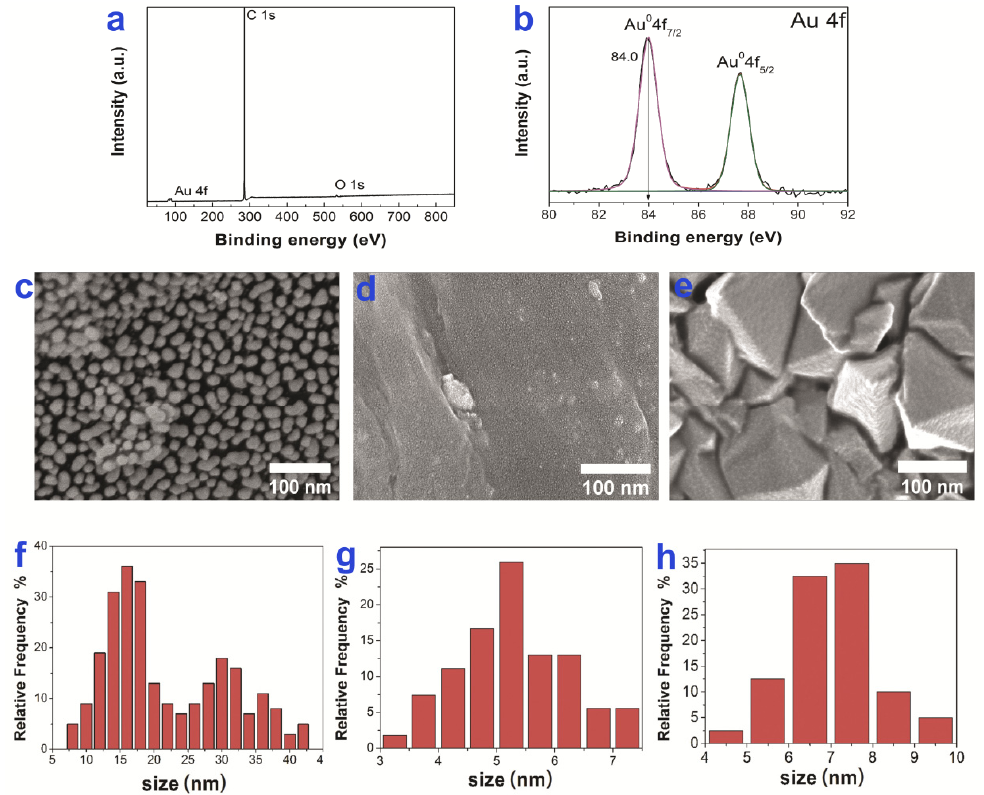
Figure 7. XPS spectra of Au/ СС M with fitting of C1s, O1s ( a ), fitting of Au4f spectra ( b ), SEM images of Au/ СС M ( c ), Au/CFR-PEEK ( d ) and Au/Pt/CFR-PEEK ( e ) with AuNPs size distributions Au/ СС M ( f ), Au/CFR-PEEK ( g ) and Au/Pt/CFR-PEEK ( h ).